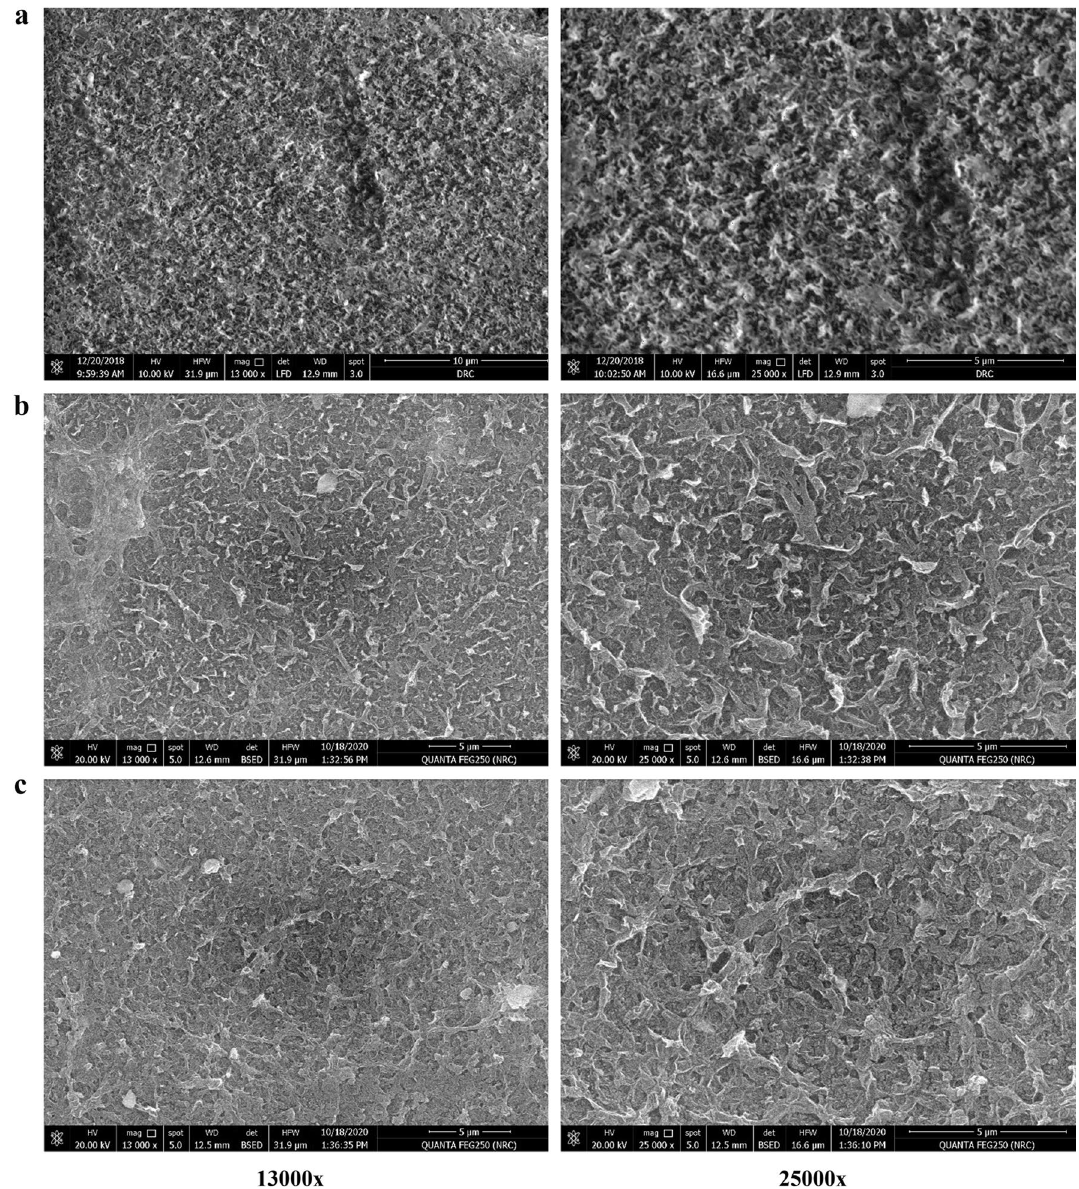
Figure 9. SEM micrographs of ( a ) TFC membrane, and ( b – e ) TFN-Al 2 O 3 membranes with varied fractions of mesoporous